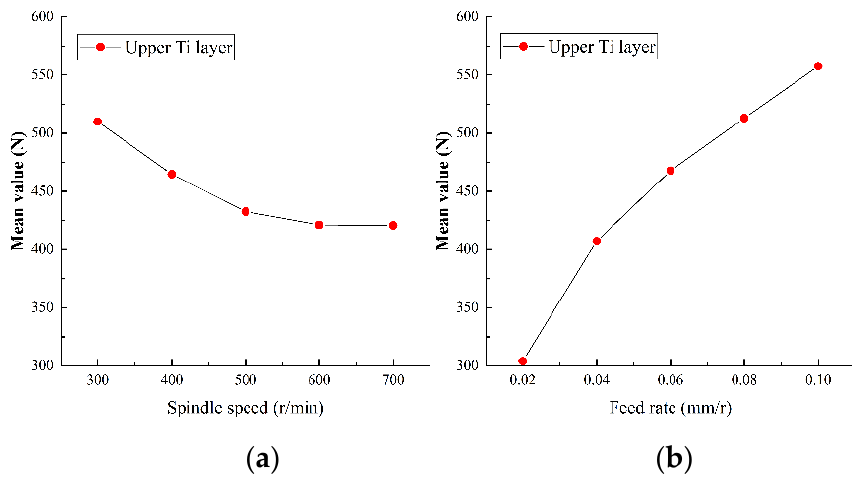
Figure 11. Main effect plots of axial force for drilling upper titanium alloy in ( a ) spindle speed and ( b ) feed rate.